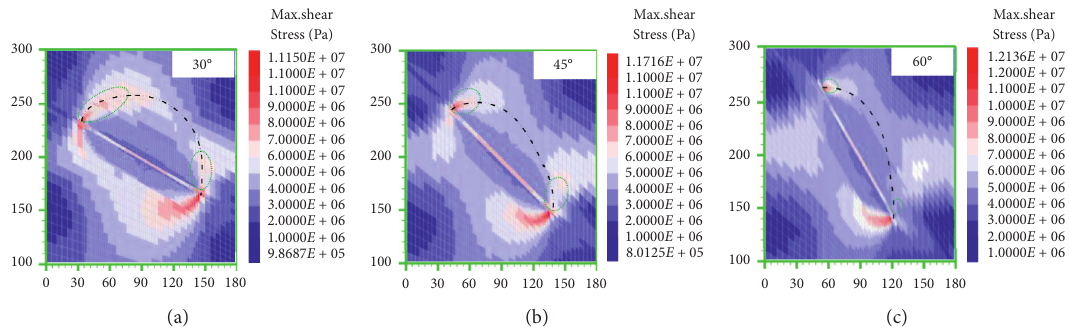
Figure 7: Distribution characteristics of maximum shear stress in different coal seam dip angles.